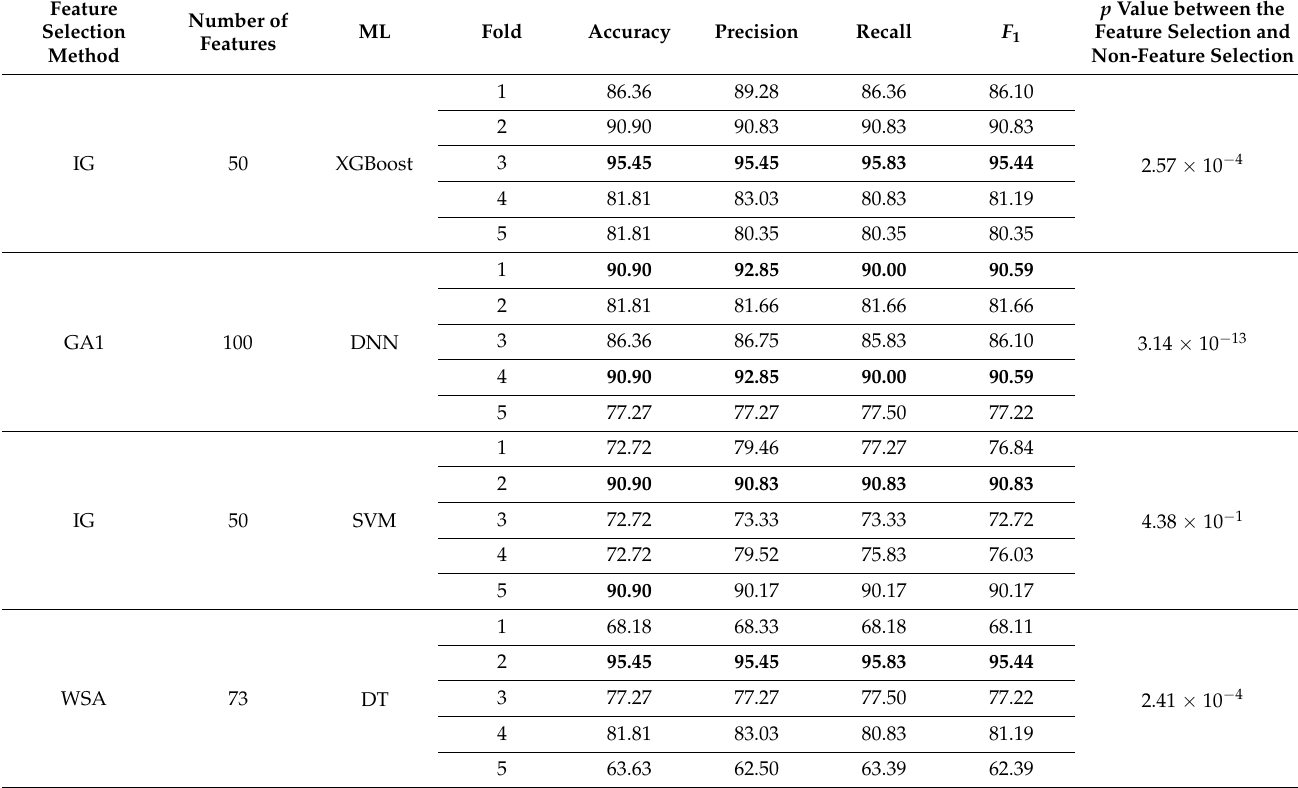
Table 4. Best Feature Selection Method by Machine Learning Model, Number of Features, and Machine Learning Performance by